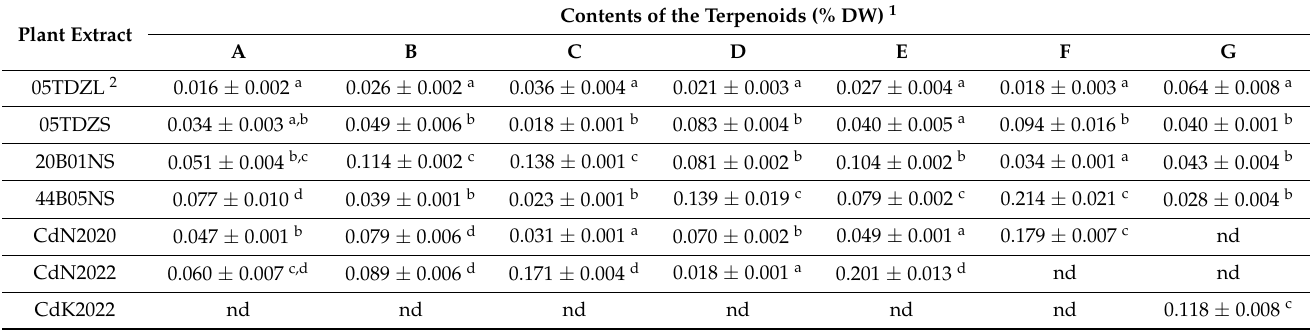
Table 2. Contents of the identified sesquiterpene lactones (A–F) and thymol derivative (G) semi- quantitatively estimated in the plant material from in vitro culture and in the organs of field- grown plants.